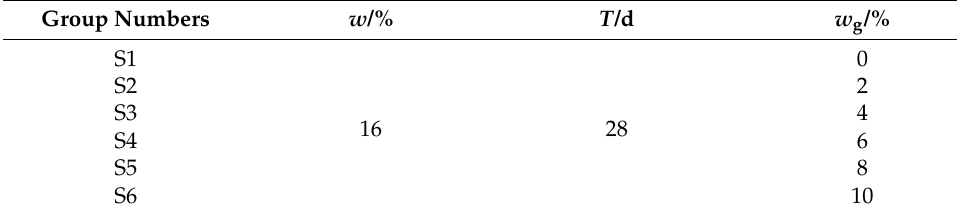
Table 3. Experimental design of SEM.